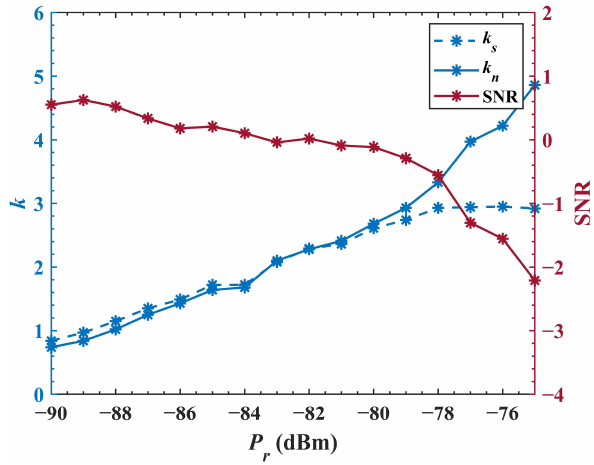
Figure 14. The mean number of photons, k s , k n , and SNR as a function of received optical power.